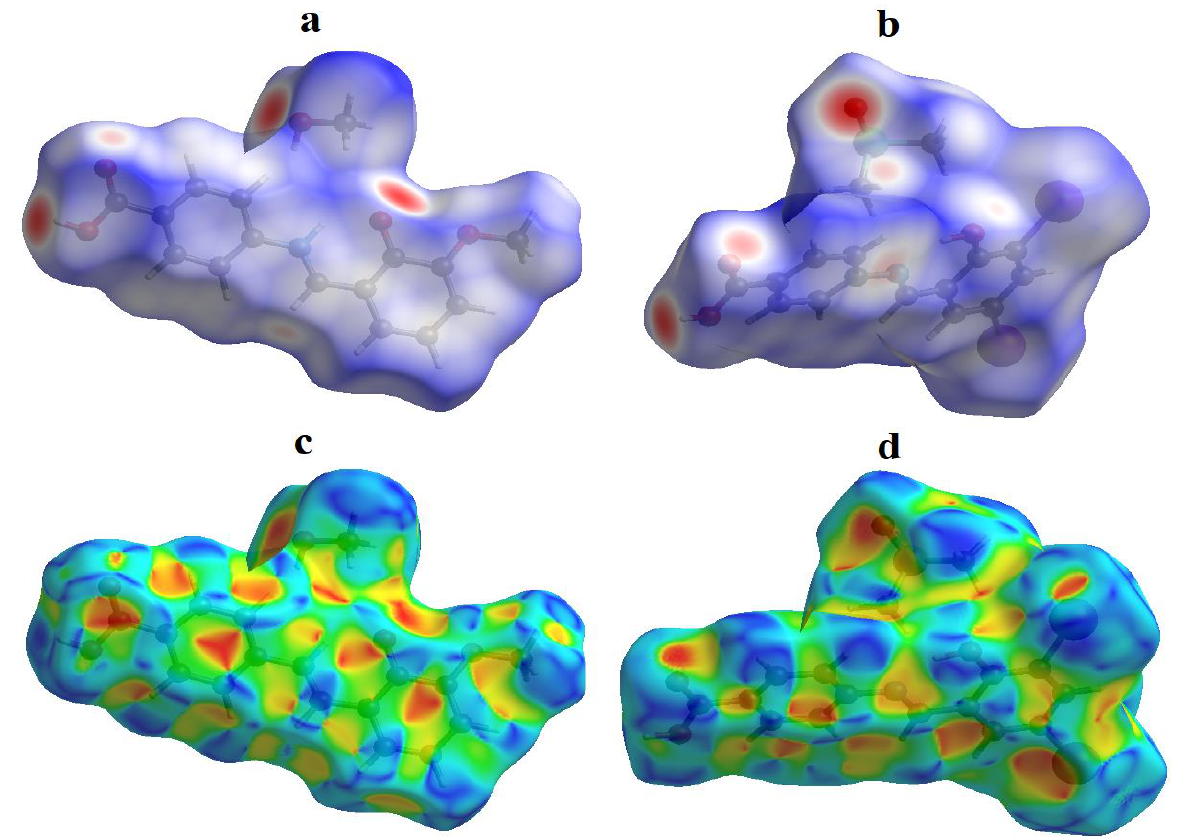
Figure 3. HS plotted over property dnorm for ( a ) HMBA in the range −0.7172 to 1.3189 a.u., ( b ) DHBA in the range −0.7444 to 1.2641 a.u. HS plotted over property shape index in the range −1 to 1 a.u. for ( c ) HMBA, ( d ) DHBA . Table 1. Hydrogen-bond geometry (Å, °) for HMBA and DHBA with C—I··· π interaction for DHBA.